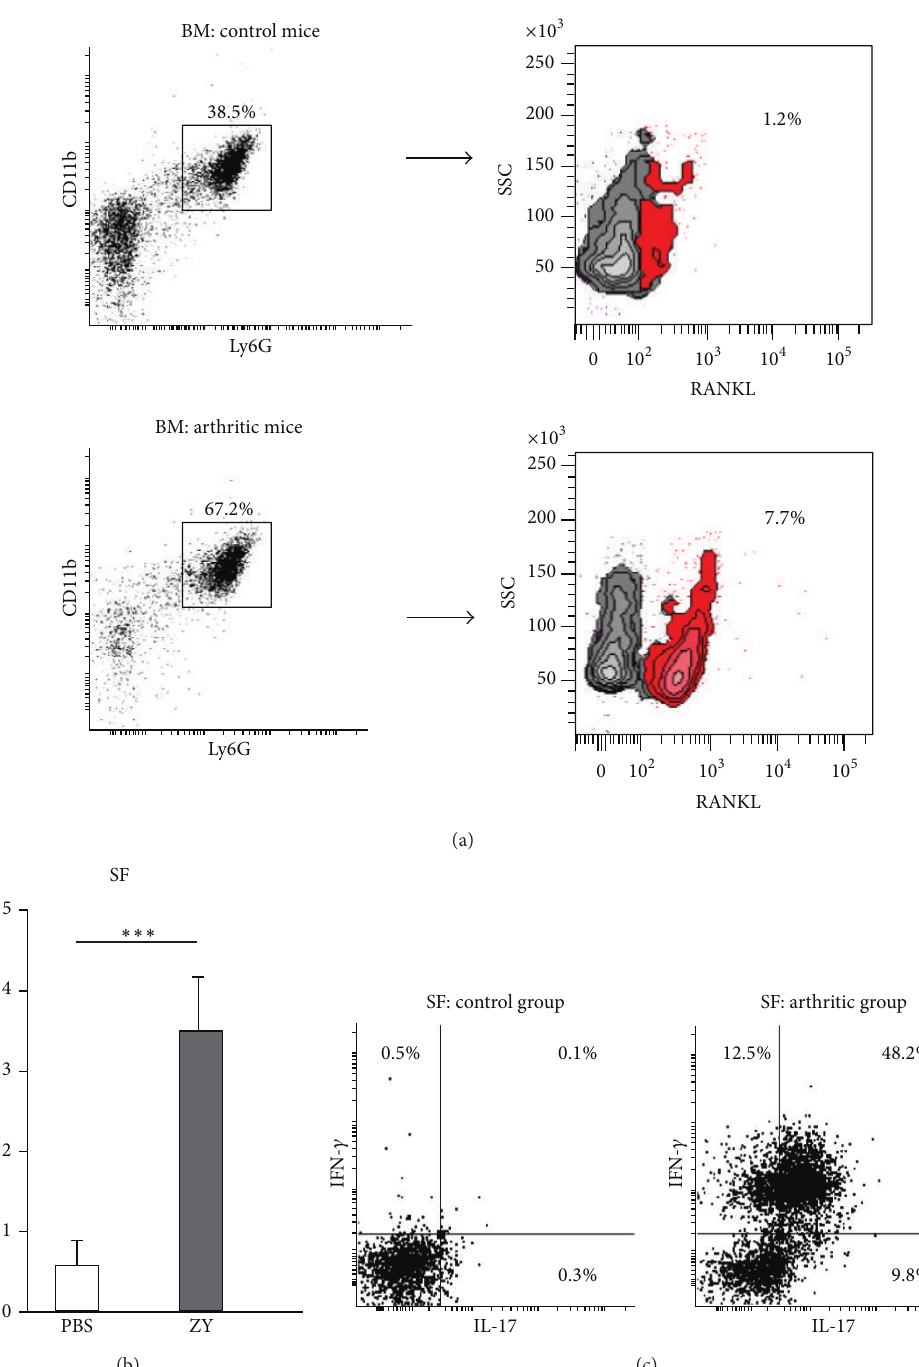
Figure 6: RANKL expression, IL-17, and IFN- 𝛾 production of Ly6G + cells in BM or SF. (a) Dot-plot histograms show increased frequencies of Ly6G + CD11b + cells in BM of mice with arthritis than in control group. The density plots indicate a higher distribution of RANKL + cells in Ly6G + CD11b + population from arthritic group (SSC: side scatter). (b) RANKL-bearing Ly6G + cells accumulated in SF of mice with arthritis. Bars represent the mean ± SEM ( 𝑛 = 5 animals/group; 3 experiments). ∗∗∗ 𝑃 < 0.001 , Student’s 𝑡 -test. (c) Synovial cells from 5 animals per group were pooled and intracellular cytokine production was performed on gated Ly6G + cells. Representative dot-plot histograms show IFN- 𝛾 and IL-17 production in Ly6G + cells from SF of mice with arthritis (day 7) ( 𝑛 = 5 animals/group; representative from 3